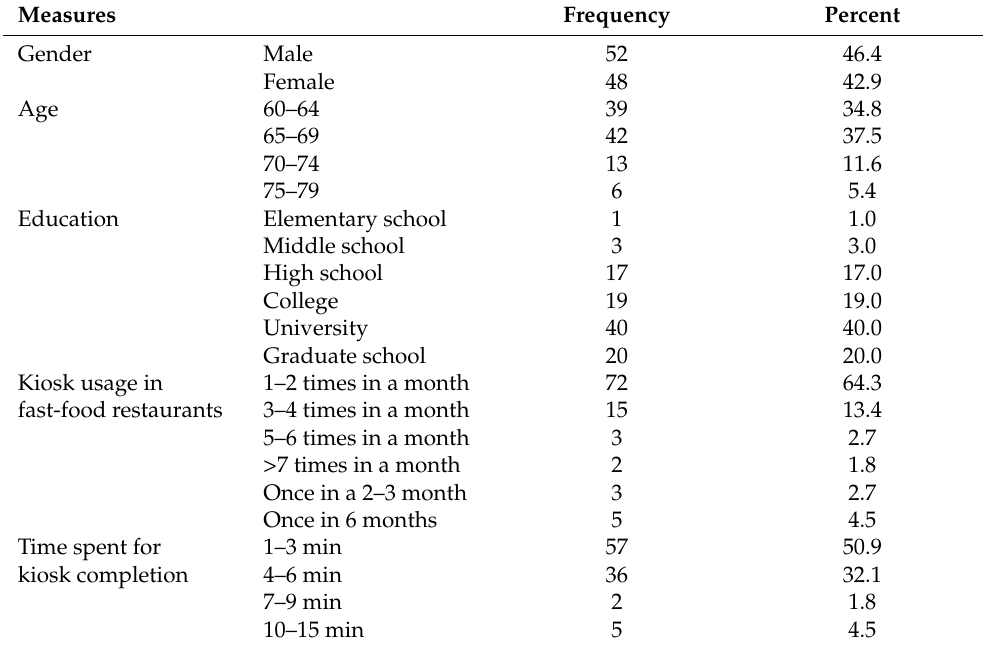
Table 1. Demographic